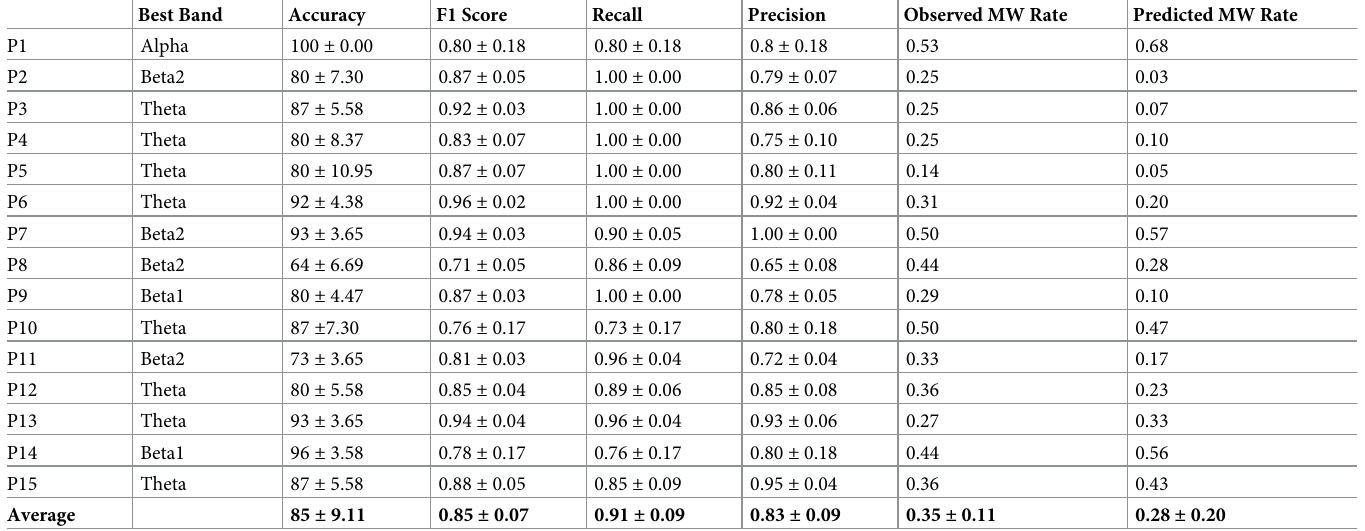
Table 7. Classification performance (with standard error across cross-validation runs) for the best frequency band using the common spatial pattern algorithm with the Artifacts Present approach. Frequency band chosen based on F1 score. Average performance (with standard deviation across participants) is given by the best frequency band for each participant. Observed MW rate reflects the MW rate of the processed epochs after epoch removal, and therefore may not be the exact rate of MW observed in the probe responses. Predicted MW rate is the rate at which the machine learning model predicts MW. Best Band